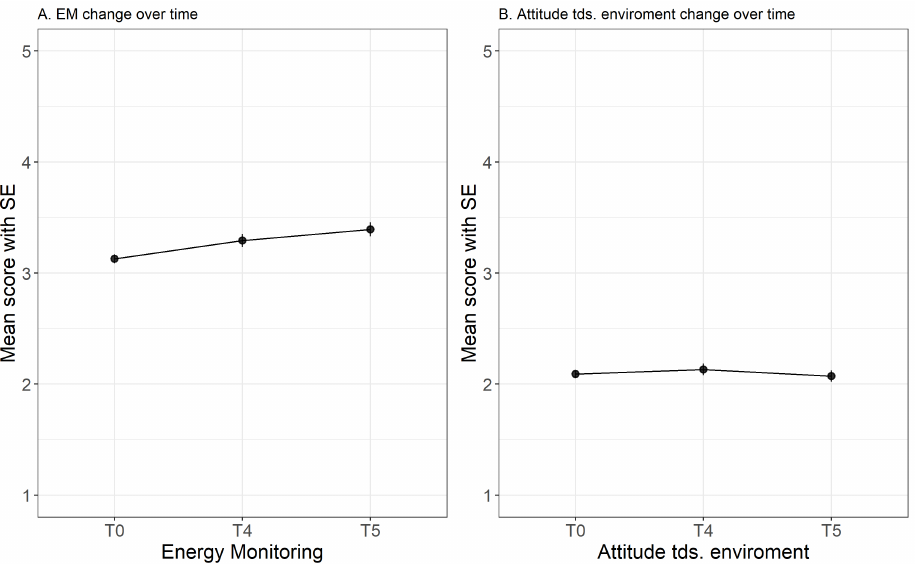
Figure 3. Mean scores with SE for repeated measurements of energy monitoring (EM) and attitude towards environmental issues